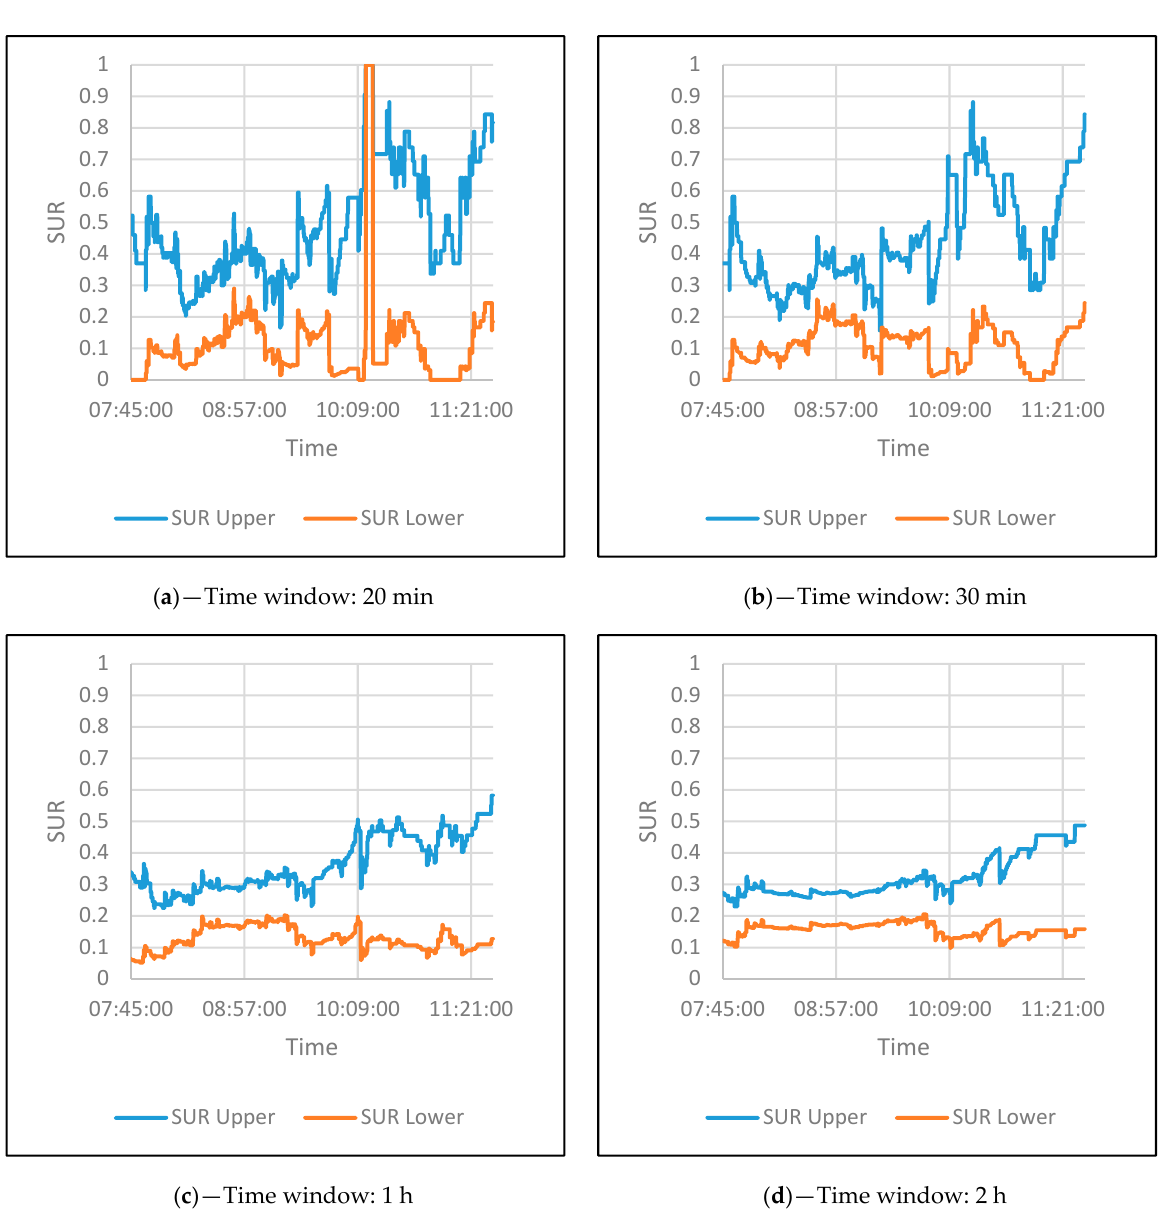
Figure 5. Time window preliminary analysis (SL4 on June 27 of 2017 is shown as an example, but more locations were considered providing similar results): ( a ) Time window of 20 min; ( b ) Time window of 30 min; ( c ) Time window of 1 h; ( d ) Time window of 2 h.